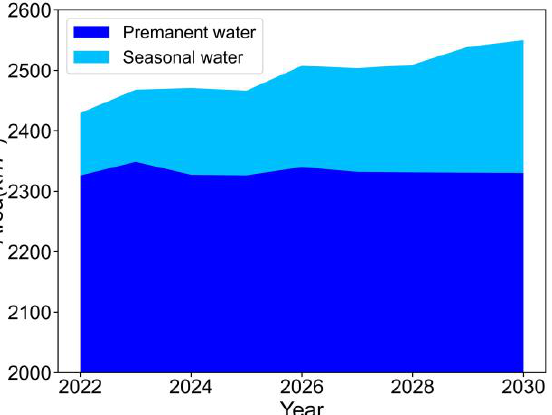
Figure 10. Predicted areal changes in the permanent and seasonal water levels of Seling Co Lake between 2022 and 2030.